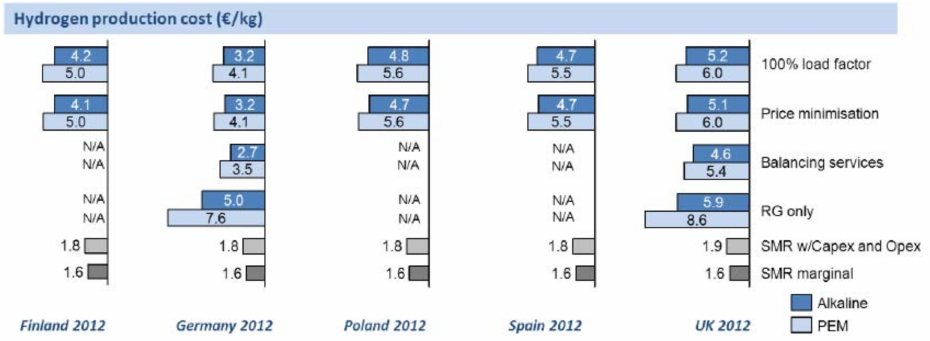
Figure 3. Hydrogen production costs in 2012 for best case KPIs for Alkaline and PEM electrolyzers in different electricity market scenarios [4].